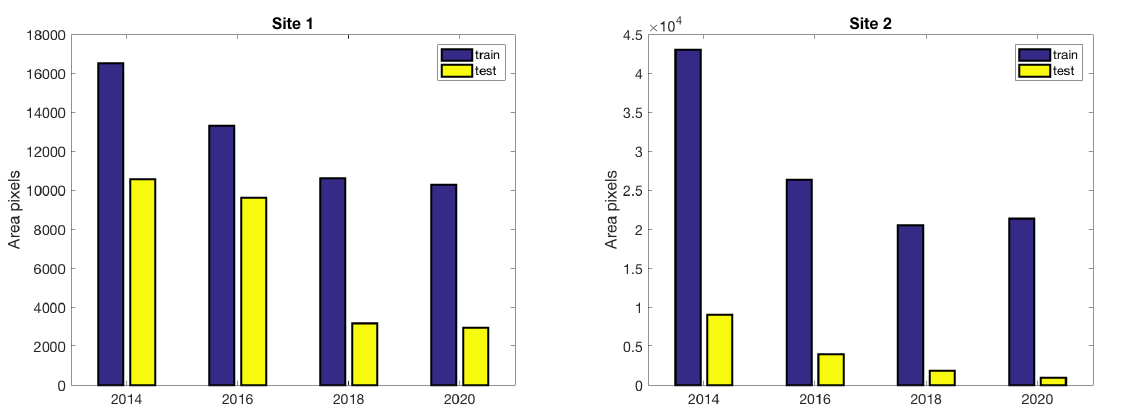
Figure 3: Spatio-Temporal Change Detection on Acacia X. Spp on Training and Test sites 1 (left) and 2 (right).